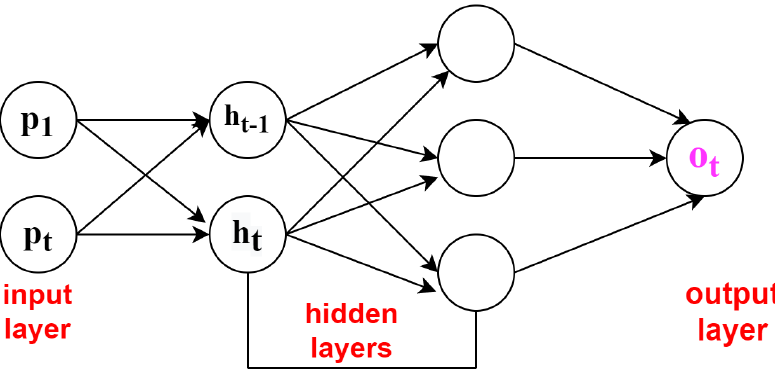
Figure 4. Lightweight deep learning classifier-convolutional neural